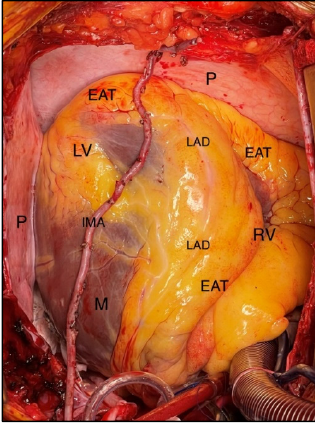
Figure 1. Intra-operative view of EAT. Left ventricle (LV); Right ventricle (RV); Left anterior descending artery (LAD); Internal mammary artery (IMA); Epicardial adipose tissue (EAT); Myocar- dium (M); Pericardium (P). Photo collected from own practice and obtained with patient’s consent. Epicardial and pericardial fat is different in many ways, including structure, origin, and vascularization. Epicardial fat originates from splanchnopleuric mesoderm, while the pericardial fat originates from the primitive thoracic mesenchyme [1–4]. As for vasculari- zation, epicardial fat is supplied by coronary arteries, while pericardial fat is supplied by branches of the internal thoracic artery [1–4,7]. The embryological origin of epicardial fat is the same as for omental and mesenteric adipose tissues [7].